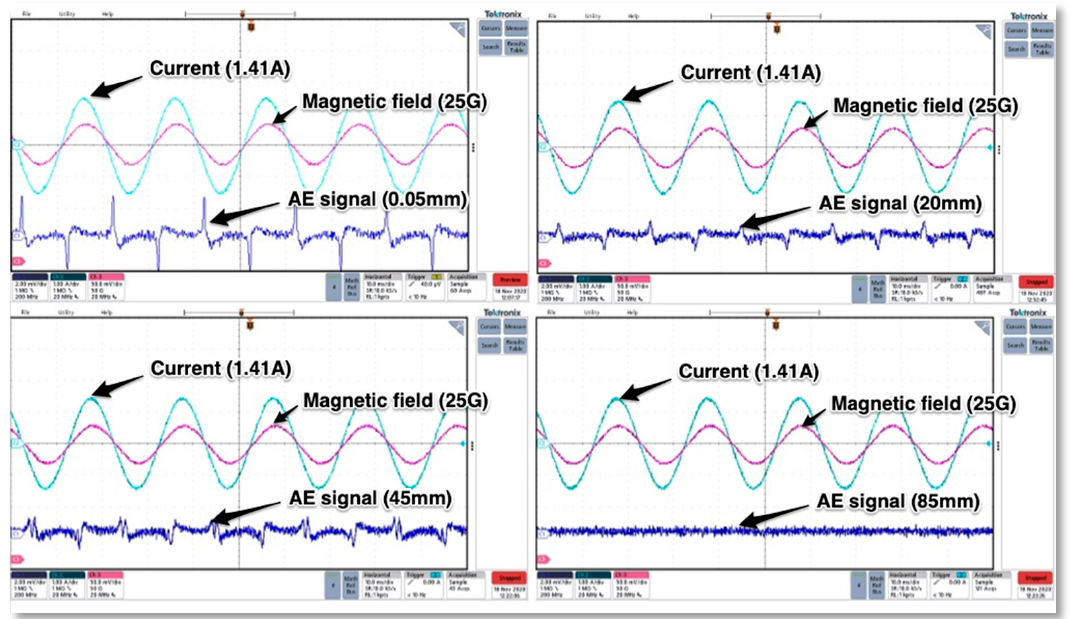
Figure 6. The magnetic field, current and AE signals obtained for different distances of the AE sensor from top of the